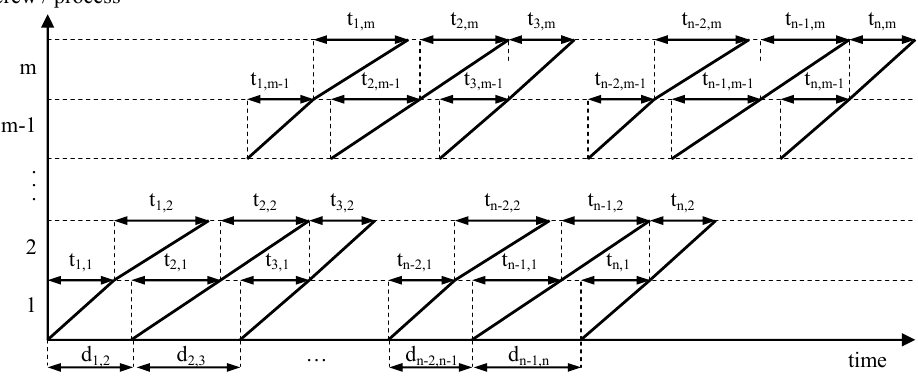
Figure 1. Project schedule illustrating a continuous process development in the work